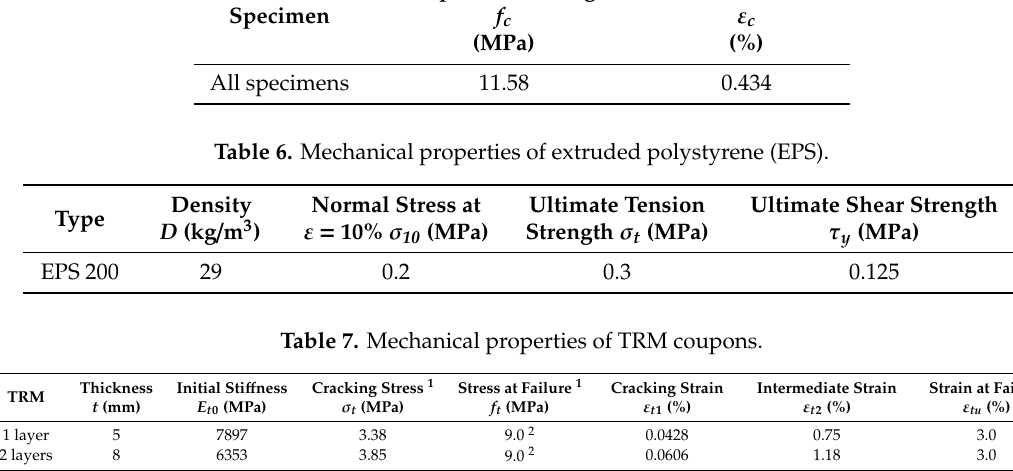
Table 5. Mechanical properties of the masonry wall.